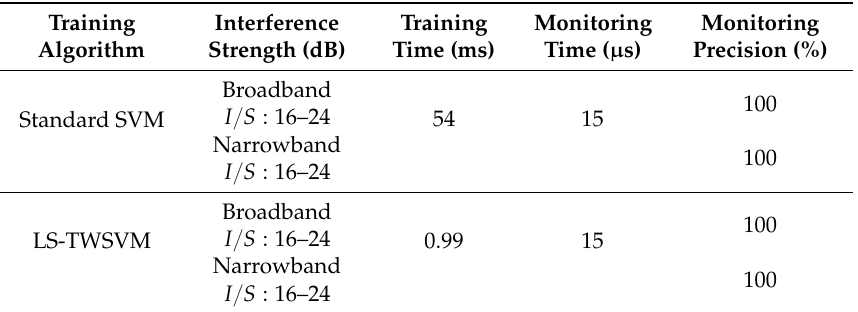
Table 3. Broadband and narrowband interference monitoring